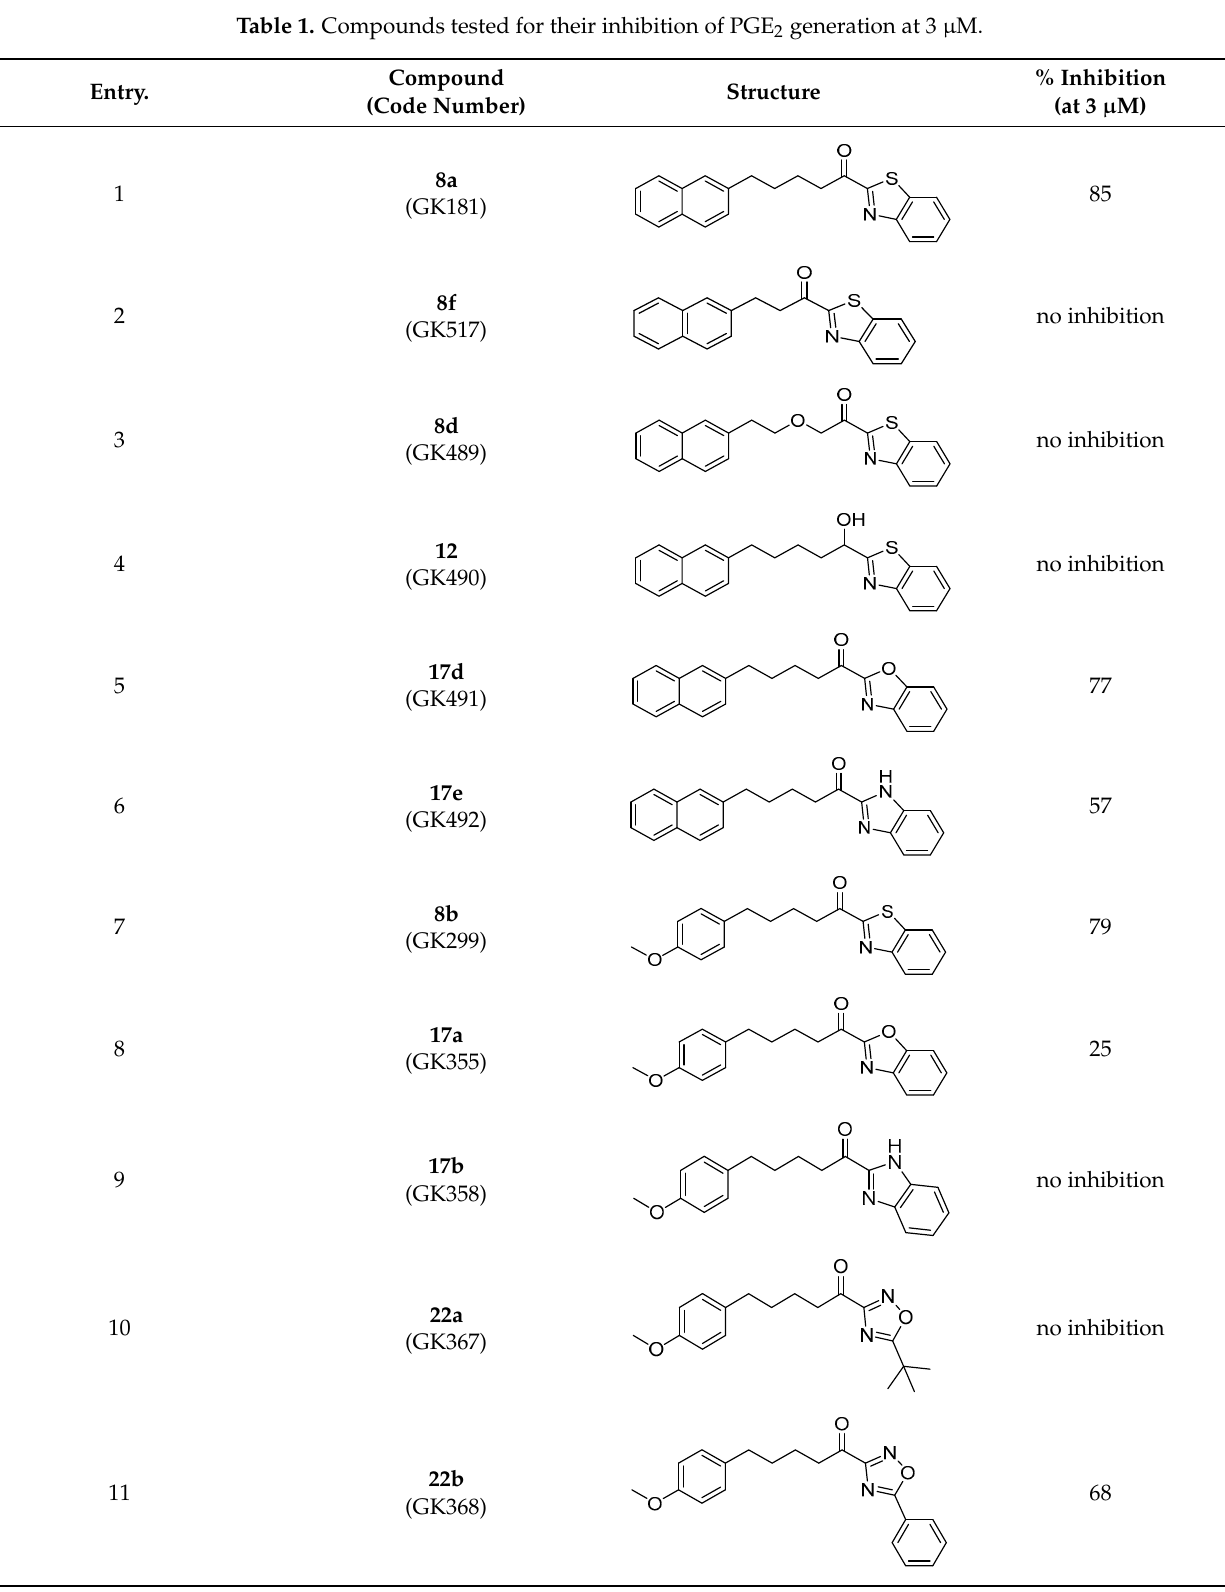
Table 1. Compounds tested for their inhibition of PGE 2 generation at 3 µM.